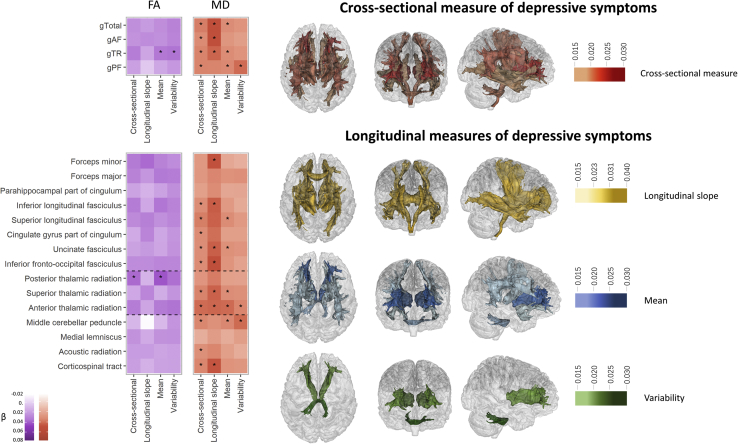
Associations between cross-sectional depressive symptoms and diffusion magnetic resonance imaging (heatmap) and the map for significant regions (brain map). For the heatmap, color depth represents the standard effect size of a measure. Because fractional anisotropy (FA) has a negative direction with mean diffusivity (MD) here in this figure, the effect sizes for FA are reversed (× −1). The results are separated into two sections. The upper sections show the results for g measures, and the lower sections show the results for individual tracts. To aid comprehension, in the lower part where results of tracts are shown, checks are divided into 3 categories by dashed lines because the tracts are in different subsets (i.e., association fibers, thalamic radiations, and projection fibers (see Methods and Materials). Significant associations after false discovery rate correction (pcorr < .05) are marked with an asterisk. For the brain map, significant tracts are shown in red for the ones associated with cross-sectional measure, yellow for the ones associated with longitudinal slope, blue if associated with the mean, and light green if associated with variability. gTotal, general variance over all tracts; gAF, general variance for tract subset of association/commissural fibers; gTR, general variance for thalamic radiation; gPF, general variance for projection fibers.